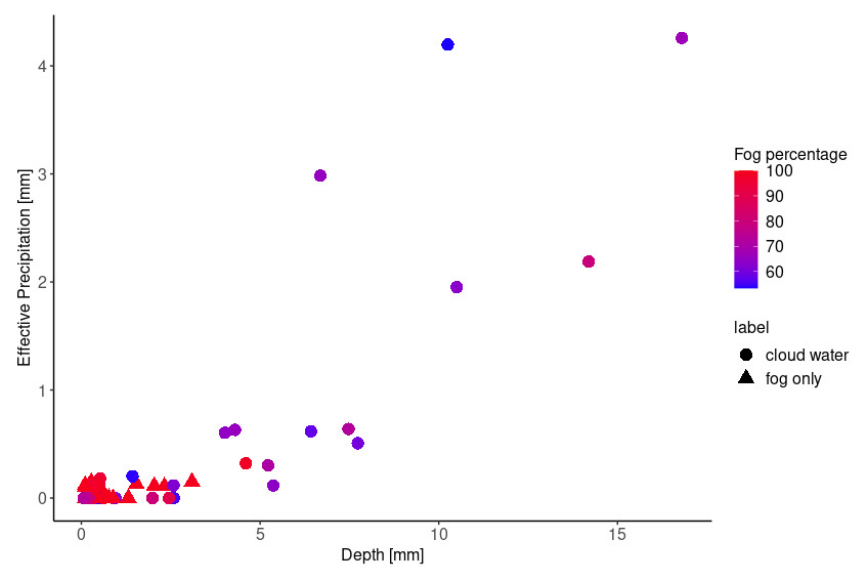
Figure 5. Relationship between events depth and effective precipitation.